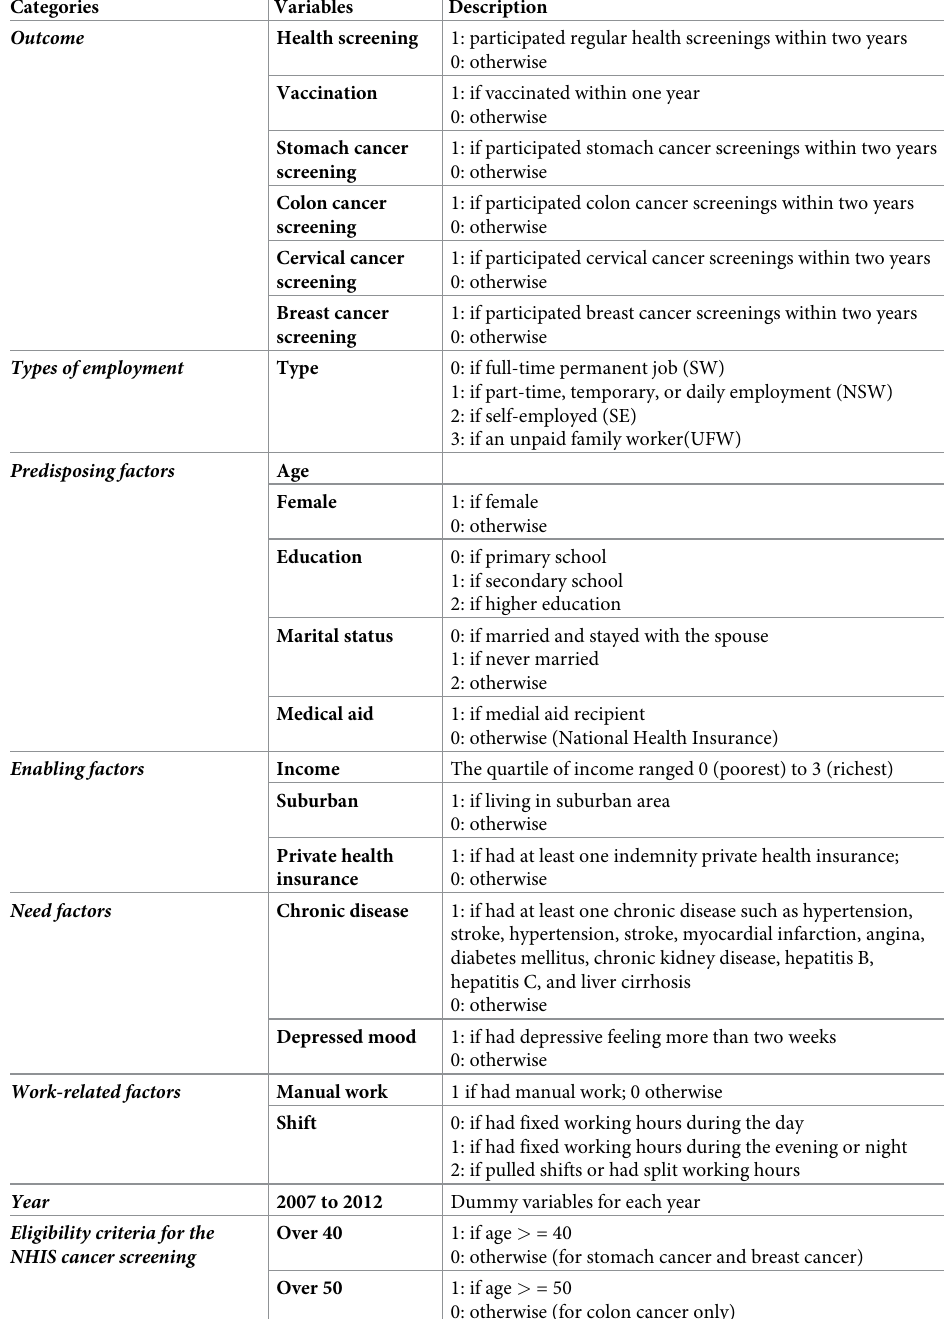
Table 1. Variables used in the